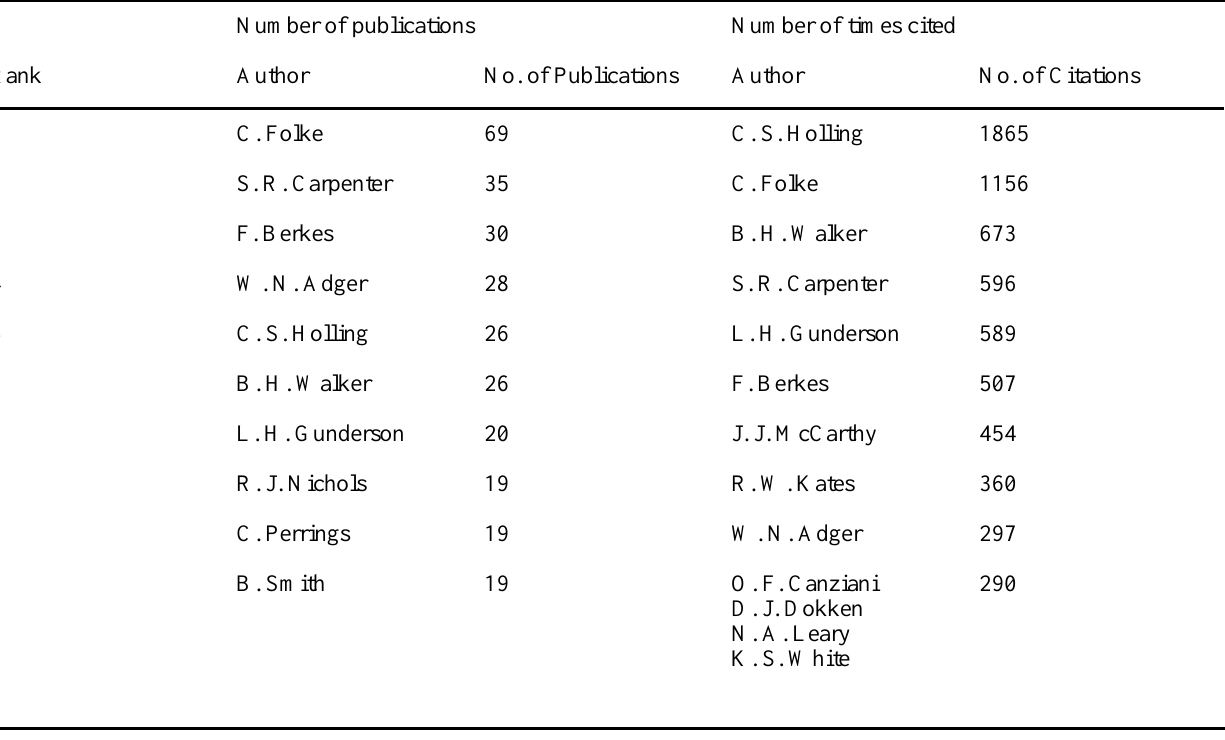
Table 5. Top-ranked authors of the complete data set. The left side of the table ranks authors (by lead author) according to number of publications. The right side of the table ranks authors (by lead author) according to number of